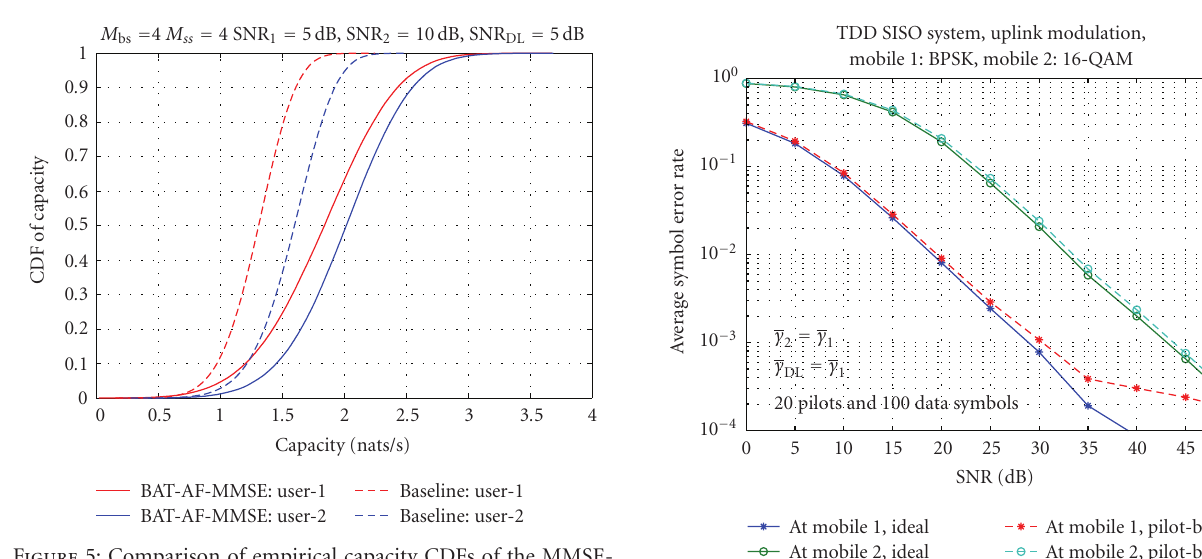
Figure 5: Comparison of empirical capacity CDFs of the MMSE- BAF system against the baseline system with 4 antennas at the base- station as well as the mobile receivers.